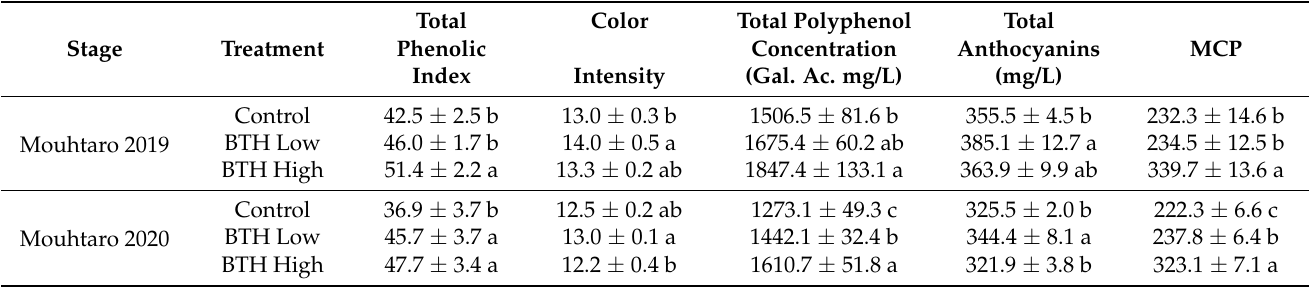
Table 7. Color and phenolic parameters of the three experimental Mouhtaro wines in response to two different BTH